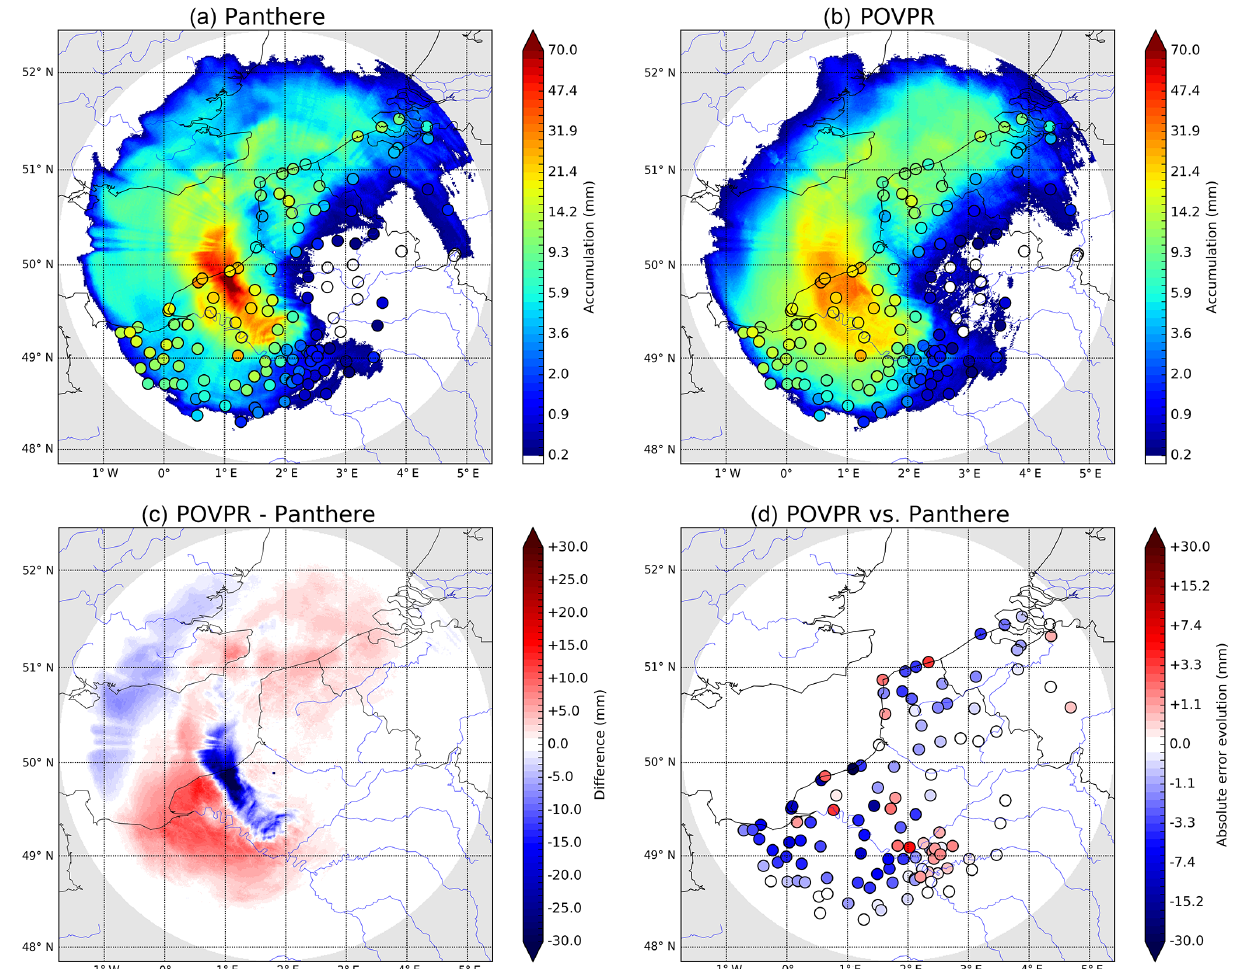
Figure 6. The 6h accumulations for the 30 April 2018 event between 03:00 and 09:00UTC on the Abbeville radar domain (255km range) with the operational method Panthere (a) and the POVPR method (b) . Rain-gauge accumulations where any precipitation has been detected by the radar are represented by circles. (c) Difference between both spatial accumulations (POVPR – Panthere). (d) Absolute error evolution between both methods at the rain-gauge